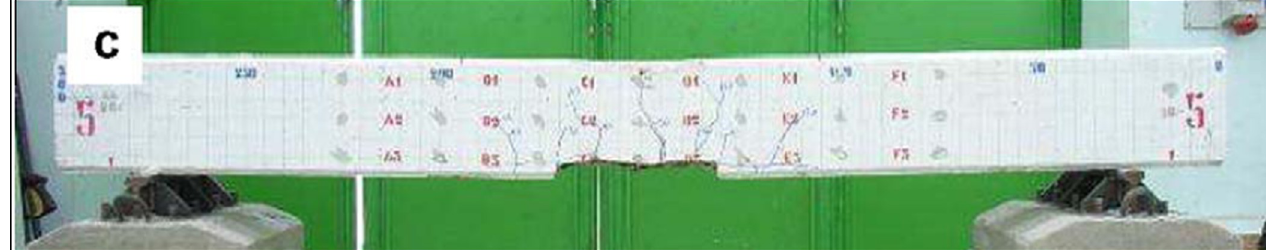
Fig 20. Failure mode of the four-point bending test